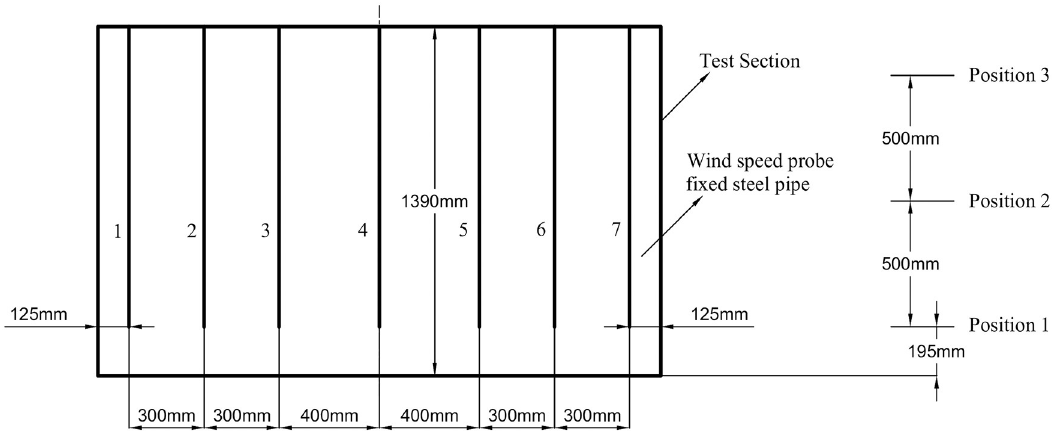
Fig 2. Schematic diagram of the measuring point